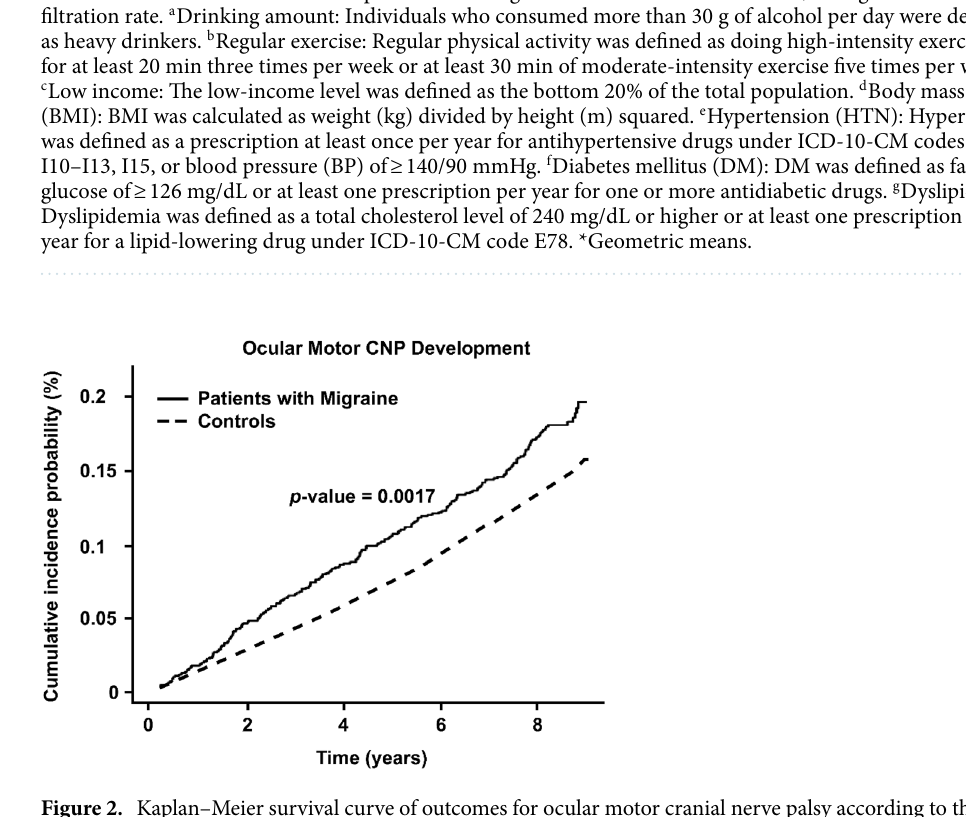
Figure 2. Kaplan–Meier survival curve of outcomes for ocular motor cranial nerve palsy according to the presence of